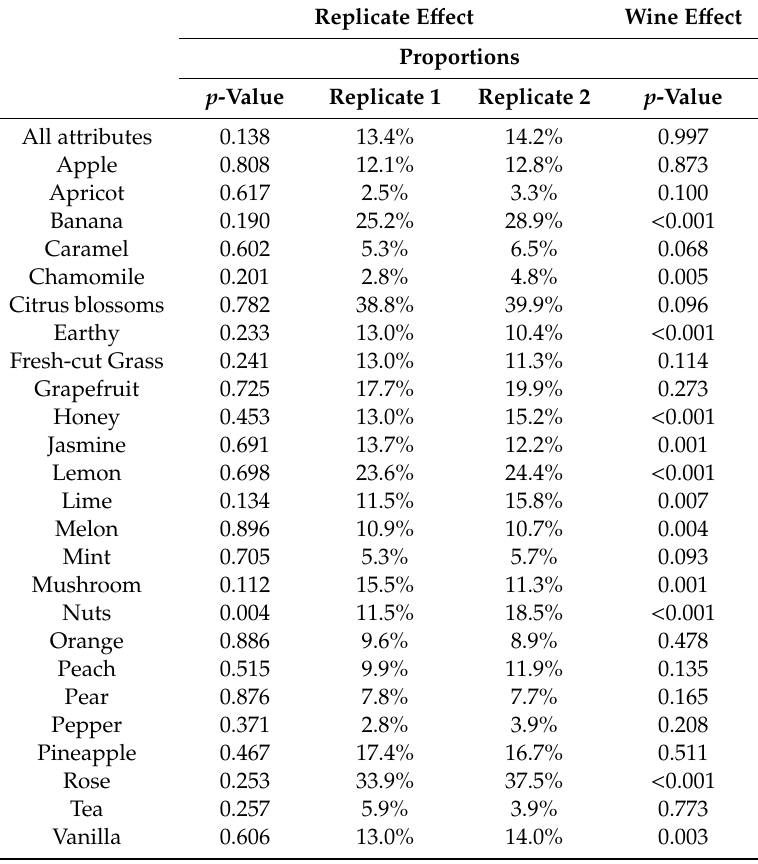
Table 4. Assessing replicate and product e ff ects using Cochran’s Q test.